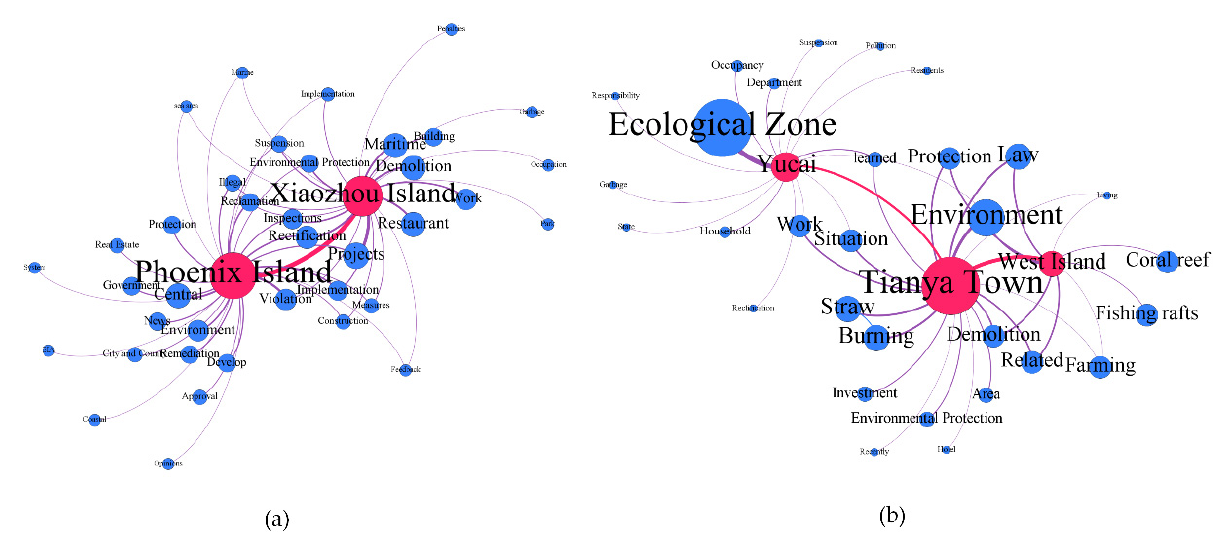
Figure 8. Construction of social semantic network based on areas with associative relationships. Among them, the figure ( a ) is the social semantic network related to “Phoenix Island” and “Xiaozhou Island”, and the figure ( b ) is the Social semantic network related to “Yucai” and “Tianya Town” and “West Island”.